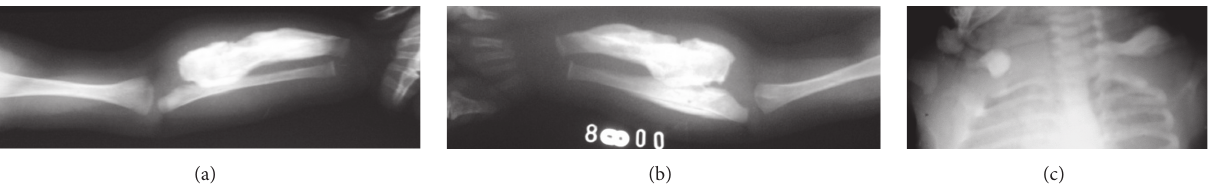
Figure 3: Massive cortical thickening of bones. ((a) and (b)) Right and left forearms are diffusely swollen. Massive irregular cortical thickening is visible in both radiuses and left ulna. All the bones beneath swellings show massive hyperostosis. (c) Thick sclerotic hyperostosis surrounding the clavicles is noted.